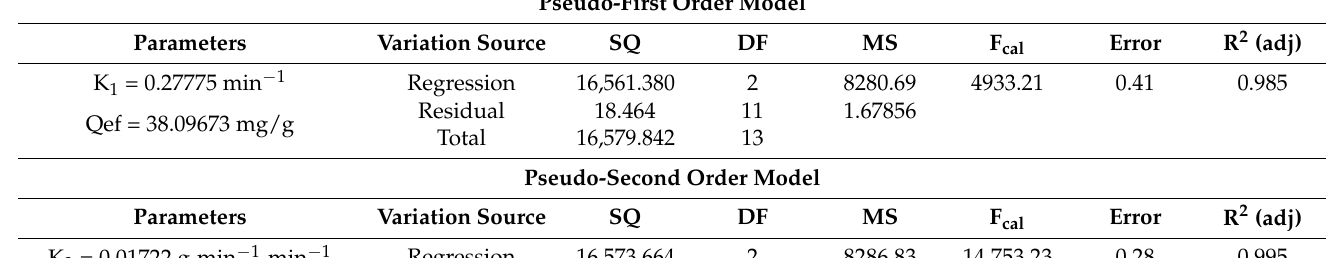
Table 9. Kinetic parameters and ANOVA obtained experimental data of SD adsorption in organo- functionalized sample fitting to the pseudo-first-order, pseudo-second-order and Elovich models. Pseudo-First Order